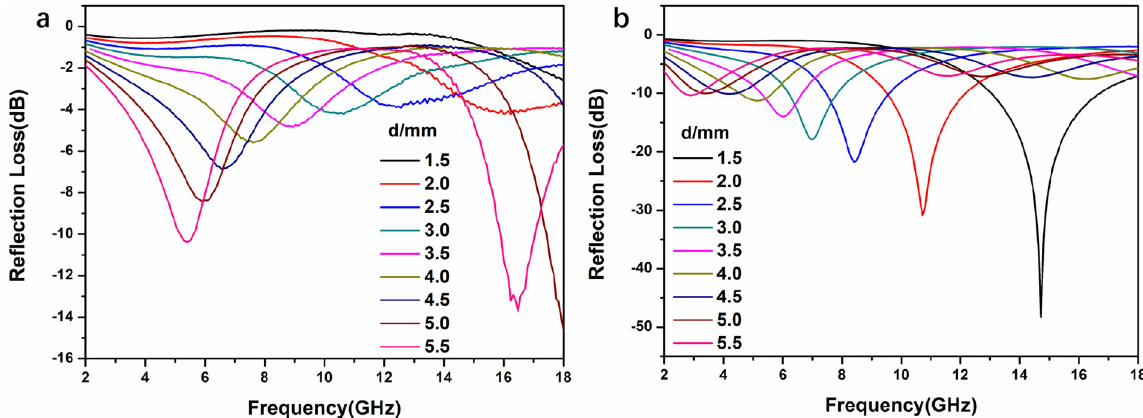
Figure 6: RL of (a) SrFe 12 O 19 nanoflakes; (b) RGO/SrFe 12 O 19